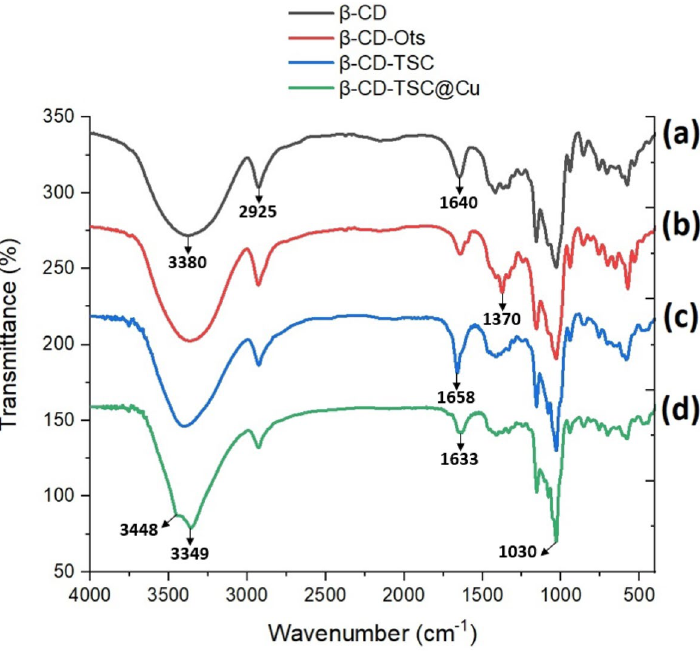
Figure 2. FT-IR spectra of ( a ) β-Cyclodextrin, ( b ) β-CD-OTs, ( c ) β-CD-TSC, and ( d ) Cu@TSC-β ‐